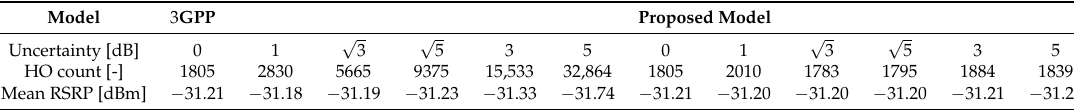
Figure 6. Experimental Cumulative Distribution Function (ECDF) of cell-level mobility models. Table 3. HO count results for cell-level mobility evaluating the performance of benchmark 3rd Generation Partnership Project (3GPP) model and proposed Deep Learning (DL) model with different levels of uncertainties present in the input measurements. 3